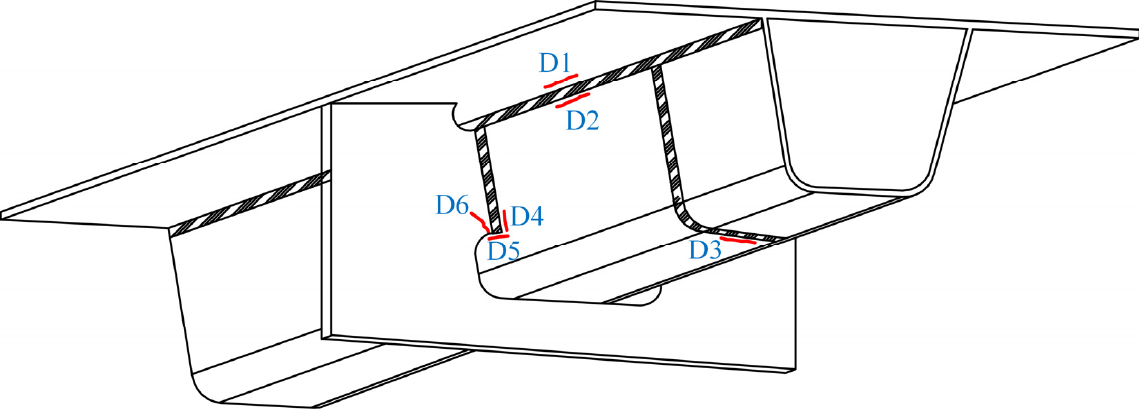
Figure 2. Fatigue details in OSDs.